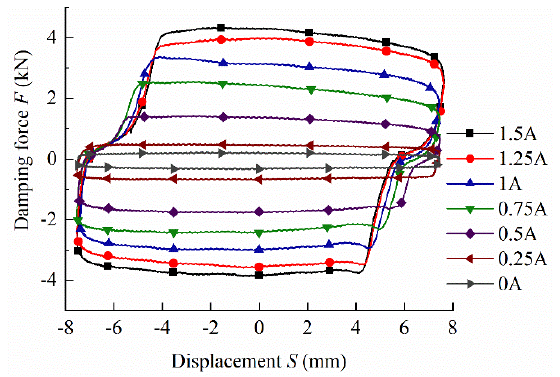
Figure 16. Damping force under different applied currents.